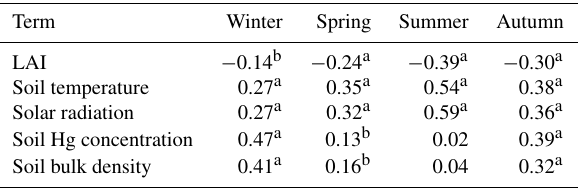
Table 4. Pearson correlations between mean total fluxes and major controlling environmental parameters in each